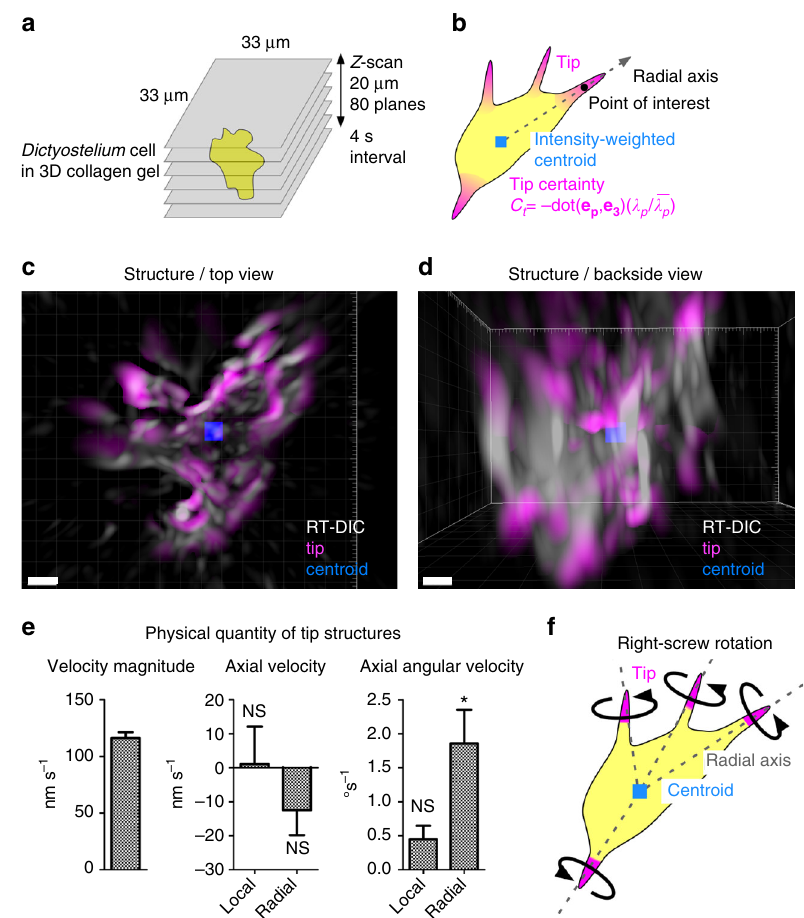
Fig. 7 Whole-cell morphology and motility analyses of Dictyostelium . a Set-up for 3D time-lapse imaging. b Identi fi cation of tip structures from the tip certainty and calculation of tip motility along the radial axis from the intensity-weighted centroid. c , d Top c and backside d views of RT-DIC intensity (gray), intensity-weighted centroid (blue) and protrusions extracted by the tip certainty (magenta). Data from cell #1 c , d . e Summary of voxel-wise instantaneous tip motility. The values represent mean ± s.e.m. of the means for individual cells ( n = 6). * P < 0.05, NS, P > 0.05. One sample t -test for the null hypothesis that the mean is equal to zero. f Right-screw rotation of tips about the radial axis revealed by the analysis. Scale bars, 5 μ